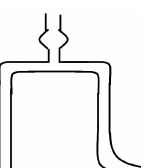
Figure 4. Schematic diagram of the Luggin capillary salt bridge.